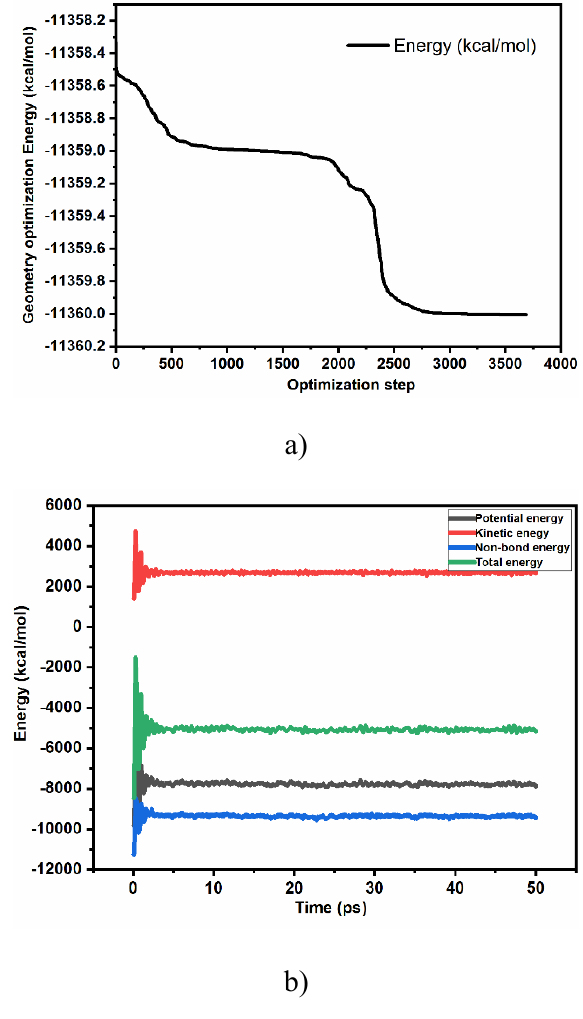
Figure 3. MD energies of MIC system after geometry optimization (a) and NVT simulation at 300.15 K